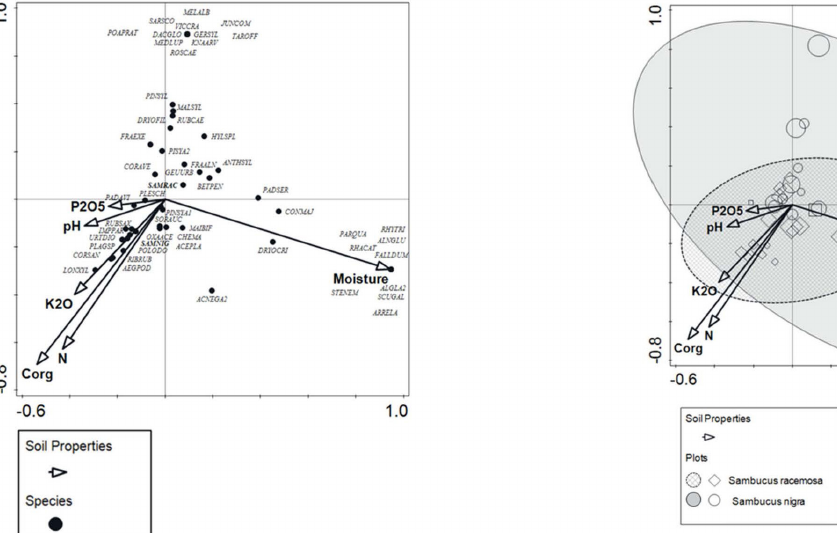
Figure 12. Canonical correspondence analyses (CCA) of Sambucus racemosa and S. nigra forest plots , soil fertility and moisture parameters. Tree species in undergrowth: QUEROB , Quercus robur ; BETPEN , Betula pendula ; FRAEXE, Fraxinus excelsior ; ACEPLA , Acer platanoides ; ALNGLU , Alnus glutinosa. Tree species in 1st stand storey: PINSYA1 , Pinus sylvestris ; BETPENA1 , Betula pendula ; PIABIA1 , Picea abies ; ACNEG1, Acer negundo . Tree species in 2nd stand storey: QUEROBA2 , Quercus robur ; PIABIA2, Picea abies ; ALGLA2 , Alnus glutinosa ; ACPLA2, Acer platanoides. Shrub species: SAMRAC , Sambucus racemosa ; SAMNIG , Sambucus nigra ; SARSCO , Sarothamnus scoparius ; FRAAL , Frangula alnus ; SORAUC, Sorbus aucuparia ; CAORAVE, Corylus avellana ; RIBRUB , Ribes rubrum ; CORSAN , Cornus sanguinea ; JUNCOM, Juniperus communis ; ROSCAE , Rosa caesius ; TAROFF , Taraxacum officinale ; PADSER, Padus serotina ; CORSAN, Cornus sanguinea ; LONXYL, Lonicera xylosteum ; RUBSAX , Rubus saxatilis ; PADAVI , Padus avium. Herb species: OXAACE, Oxalis acetosella ; MYCMUR, Mycelis muralis ; PTEAQU, Pteridium aquilinum ; LUZPIL, Luzula pilosa ; VACMYR, Vaccinium vitis-idaea ; HUMLUP, Humulus lupulus ; CONMAJ, Convallaria majalis ; IMPPAR, Impatiens parviflora ; CHEMA, Chelidonium majus ; POAPRA , Poa pratensis ; MAIBIF , Maianthemum bifolium ; DACGLO , Dactylis glomerata ; MEDLUP , Medicago lupulina ; KNAARV , Knautia arvensis ; GERSYL , Geranium sylvaticum ; MELALB , Melilotus albus ; VICCRA , Vicia cracca ; DRYOFIL , Dryopteris filix-mas ; DRYOCRI , Dryopteris cristata ; FALLDUM, Fallopia dumetorum ; ARRELA , Arrhenatherum elatius ; GEUURB , Geum urbanum